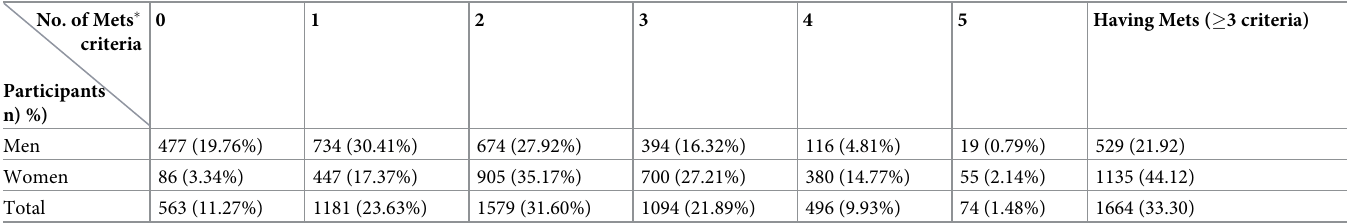
The mean (SD) values of biochemical parameters at the primary phase are presented in S1 Table. The levels of fasting blood sugar (102.81 (33.40) vs . 100.95 (30.78), P-value = 0.041), total cholesterol (178.53 (36.12) vs . 171.49 (37.95), P-value < 0.001), and high density lipopro- tein (HDL) (44.90 (9.61) vs . 39.12 (8.37), P-value < 0.001) levels were higher in women com- pared to men. Although, the values for hemoglobin (15.51 (1.42) vs . 13.57 (1.37), P- value < 0.001), blood urea nitrogen (30.87 (7.87) vs . 26.96 (7.74), P-value < 0.001), creatinine (1.19 (0.18) vs . 0.95 (0.15), P-value < 0.001), triglyceride (159.74 (103.61) vs . 141.42 (79.55), P- value < 0.001), serum glutamic-oxaloacetic transaminase (19.78 (11.31) vs . 16.73 (6.84), P-